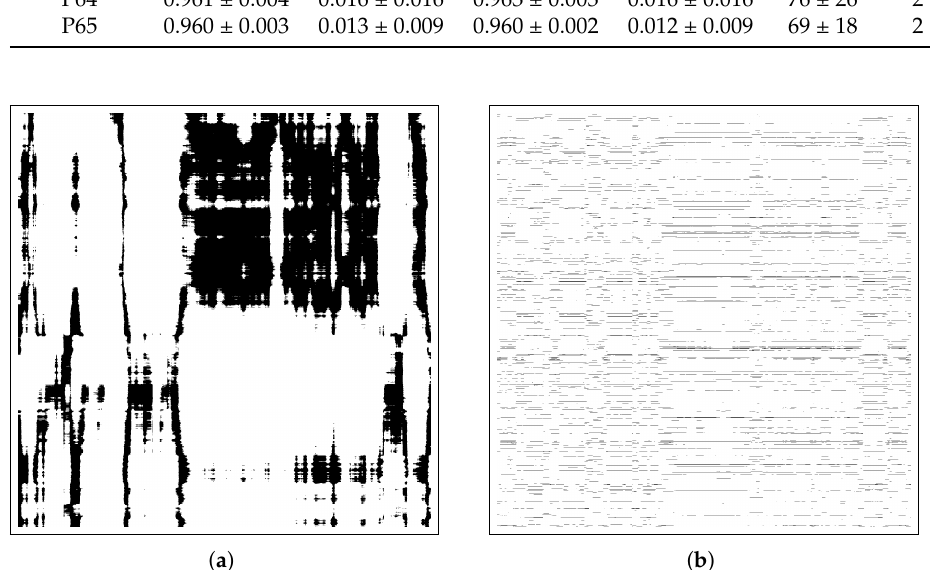
Figure 5. Cross recurrence plots of the trajectories from human raters compared against an emulated rater and a random rater. The x - and y -axes represent the time axes of the V/A trajectories generated by the synthetic and human rater, respectively. Each point in the matrix visualises as a binary value (black: near, white: far) the adjacency of two V/A points in the respective trajectories. Off-diagonal dots represent adjacency at different time lags. ( a ) emulated rater vs. human rater; ( b ) random rater vs. human